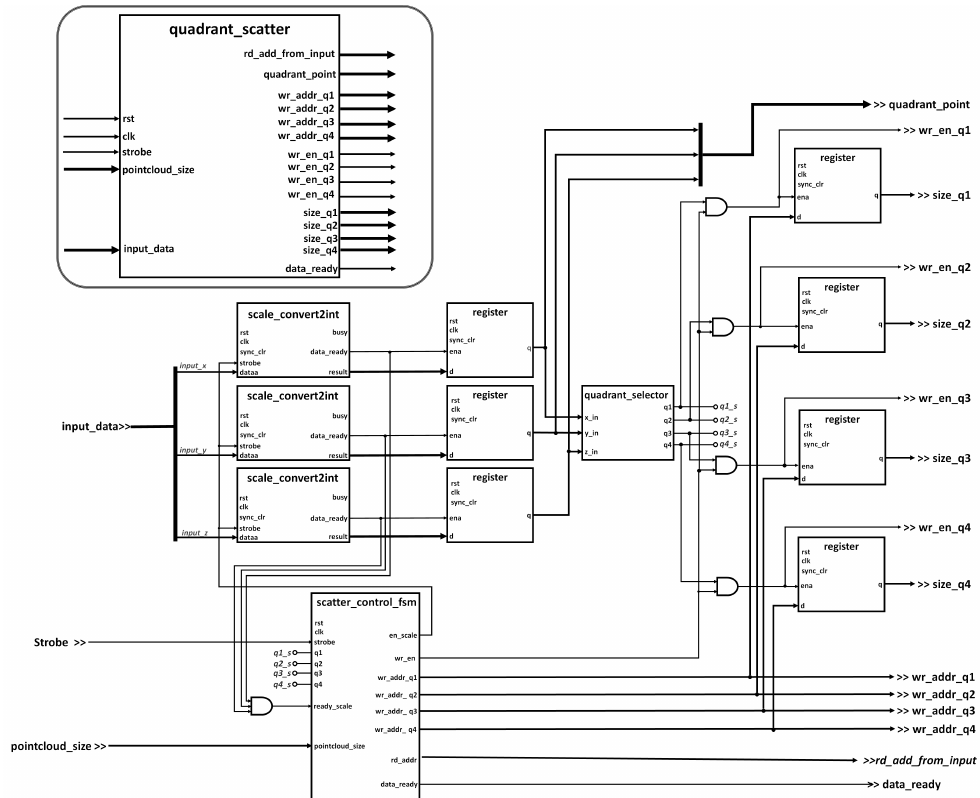
Figure 6. Internal architecture of the quadrant scatter